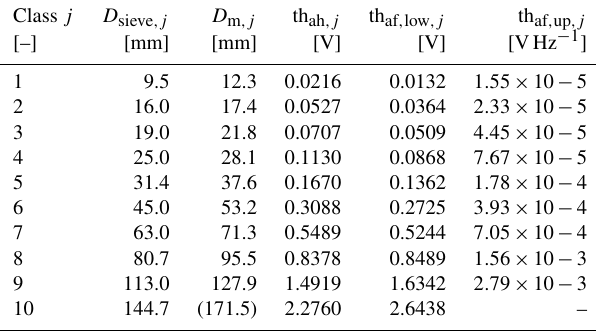
Table 3. Characteristics of the size classes j according to Wyss et al. (2016a) with the sieve mesh sizes D sieve ,j , the mean particle diameter D m ,j , and the amplitude histogram thresholds th ah ,j de- rived from Eq. (1). Additionally, the lower and upper amplitude– frequency thresholds th af , low ,j and th af , up ,j respectively derived from Eqs. (4) and (5) are provided (see Sect. 2.5.2). The value of D m ,j for the largest class (10) in brackets is an estimate because this size class is open-ended, and as such the mean varied some- what from site to site. Class j D sieve